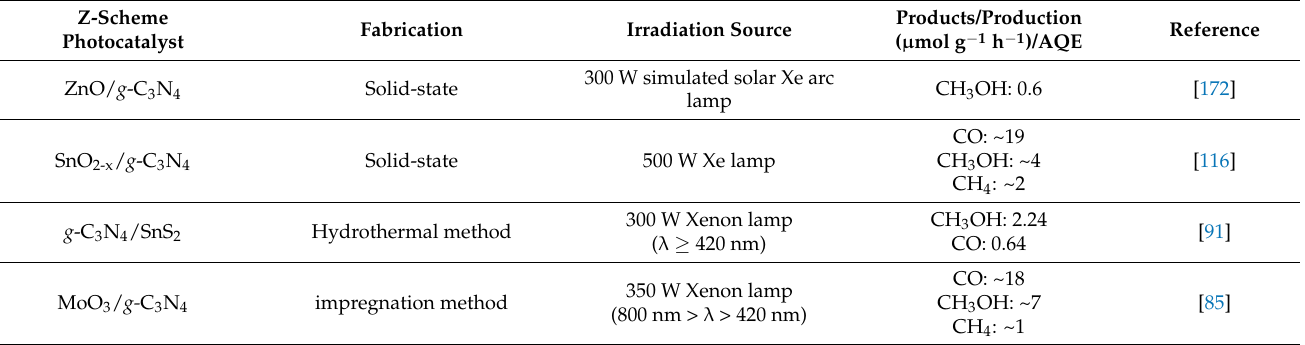
Table 3. Summary of direct Z-scheme photocatalysts based on g -C 3 N 4 for CO 2 photoreduction.